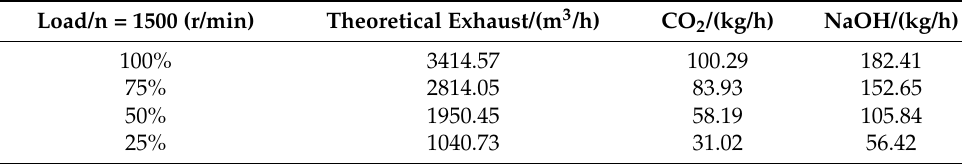
Table 8. Quantity of NaOH required in the experiment.